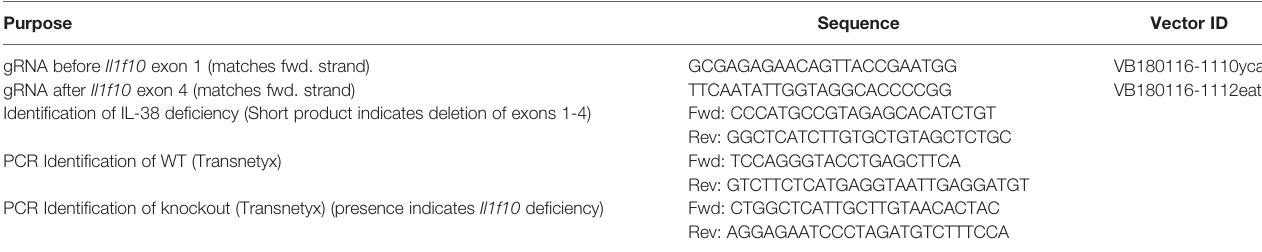
TABLE 1 | gRNA and PCR primer